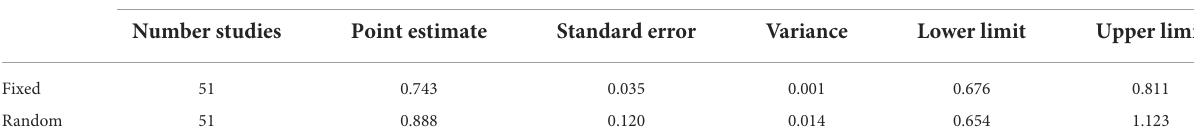
TABLE 3 Summary effect of the intervention on metaphorical competence.